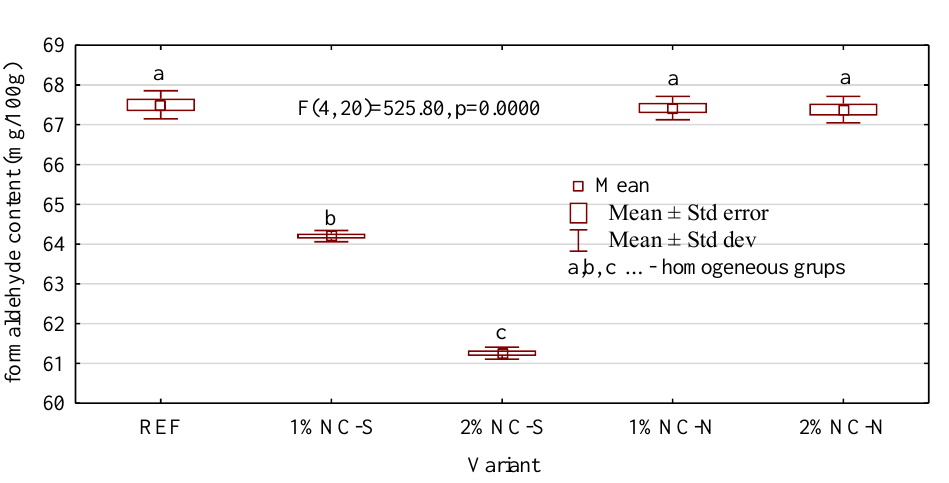
Figure 7. Formaldehyde content in cured adhesive.